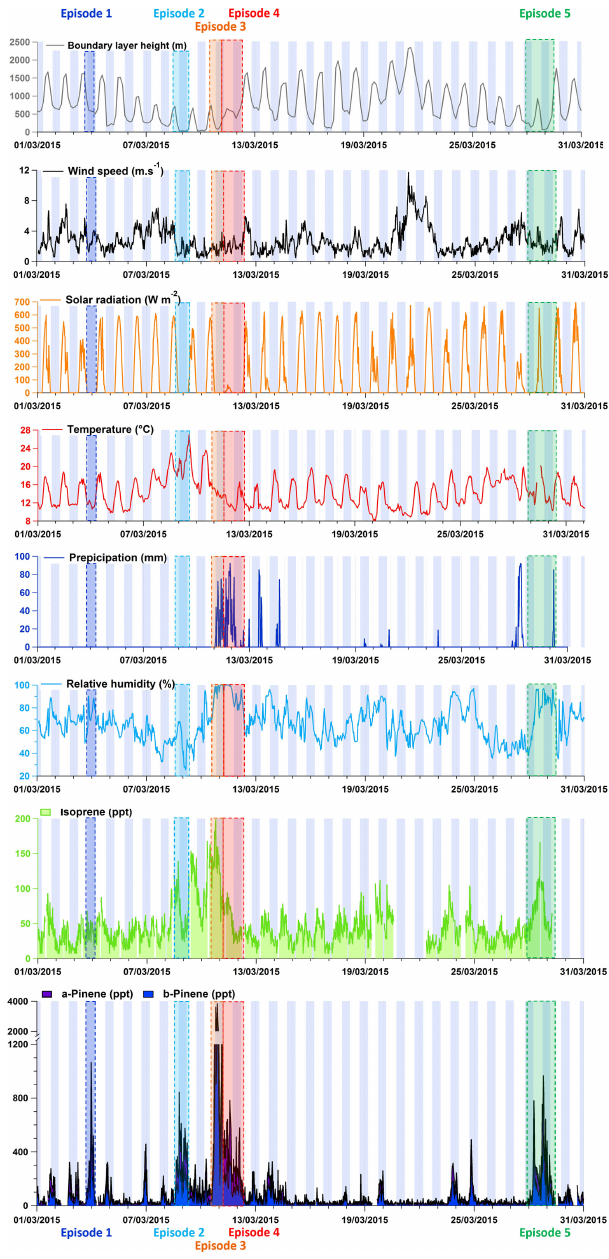
Figure 5. Time series of isoprene and a selection of monoterpenes ( α -pinene and β -pinene) in comparison to time series of meteoro- logical parameters (boundary layer height, wind speed, solar radi- ation, temperature, precipitation and relative humidity). Blue rect- angles correspond to nighttime periods. BVOC episodes 1 to 5 re- ferred to specific BVOC variations discussed in Sect. 3.2. Note that PBL assimilated data were generated by the ECMWF ERA-Interim global atmospheric reanalysis at the location corresponding to the Troodos station (34.92 ◦ N, 32.88 ◦ E; ∼ 20km west of the CAO sta-